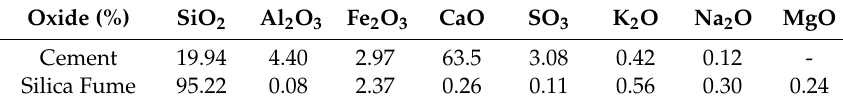
Table 2. Chemical composition of Portland cement and silica fume.